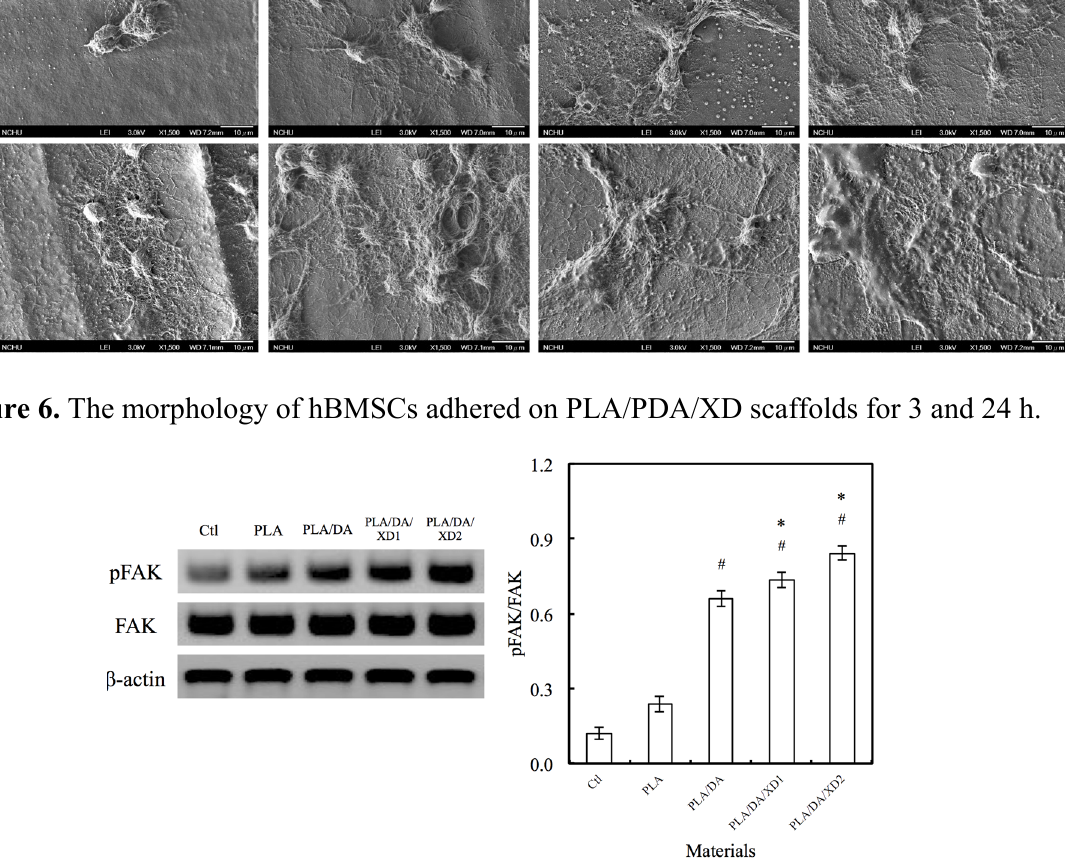
Figure 7. The pFAK expression of hBMSCs cultured on various specimens for 3